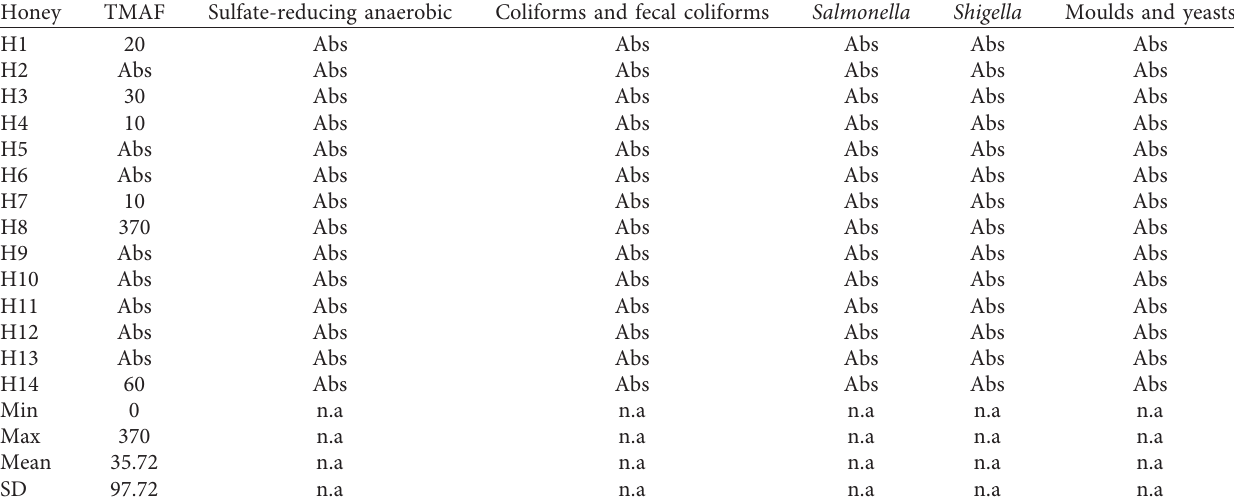
Table 2: Microbial profiles (in cfu/g) of the honey